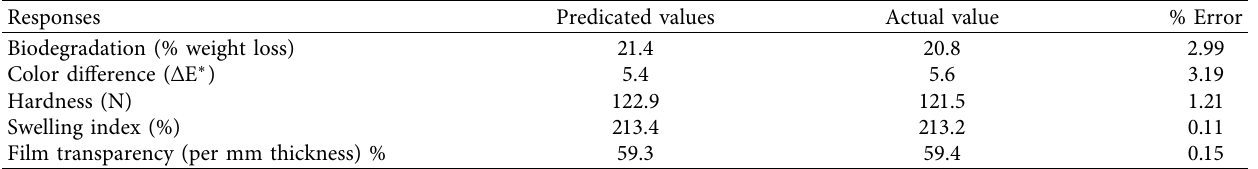
Table 5: Validation of developed natural gum-based hydrogel film.